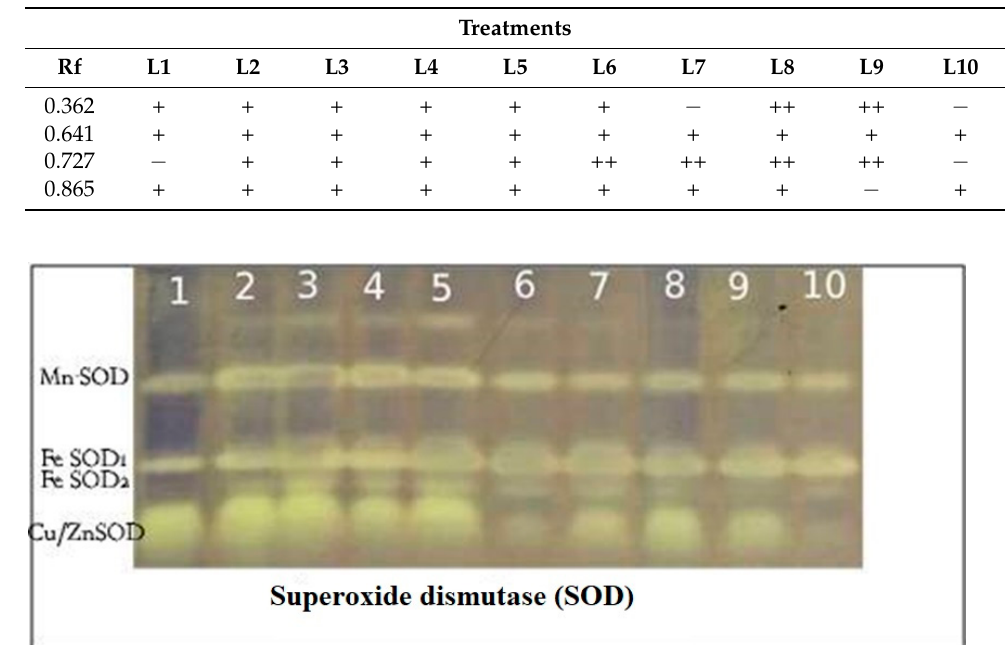
Figure 9. Effect of salinity (S) and foliar application of chitosan dissolved in different organic acids (Ch ACE, Ch ASC, Ch CIT and Ch MAL) and their interactions on Superoxide dismutase (SOD) isozyme of tomato plants. Table 5. Isomers of superoxide dismutase enzymes (+/ − ) and their Retention factor (Rf) in re- sponse to salinity stress, foliar application of chitosan dissolved in different organic acids (Ch ACE, Ch ASC, Ch CIT and Ch MAL) and their interactions on tomato plants. L1 = Control, L2 = Ch ACE, L3 = Ch ASC, L4 = Ch CIT, L5 = Ch MAL, L6 = S, L7 = S + Ch ACE, L8 = S + Ch ASC, L9 = S + Ch CIT and L10 = S + Ch MAL.